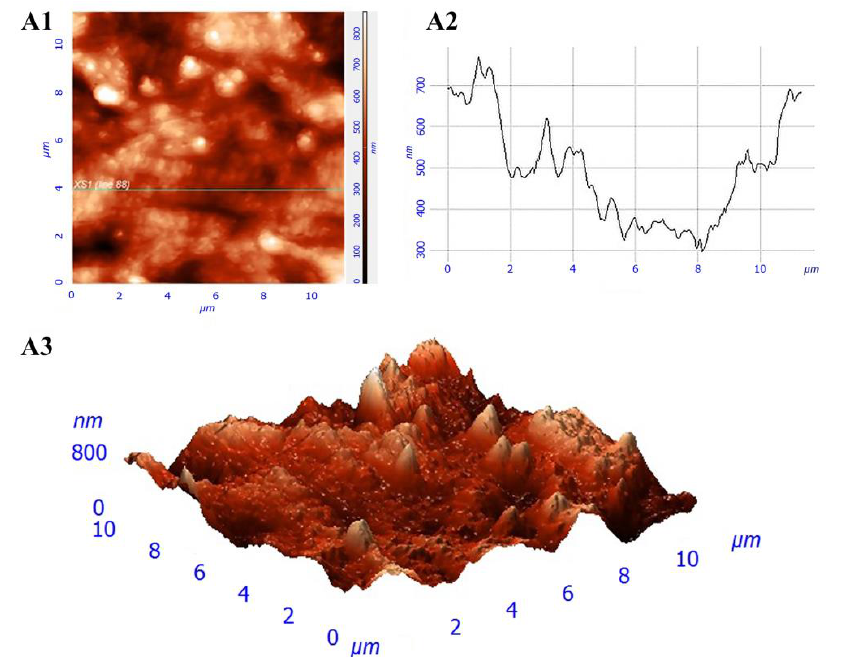
Figure 2. Film structure: ( A1 ) surface image; ( A2 ) surface profile along the specified line; and ( A3 ) three-dimensional image of the surface.